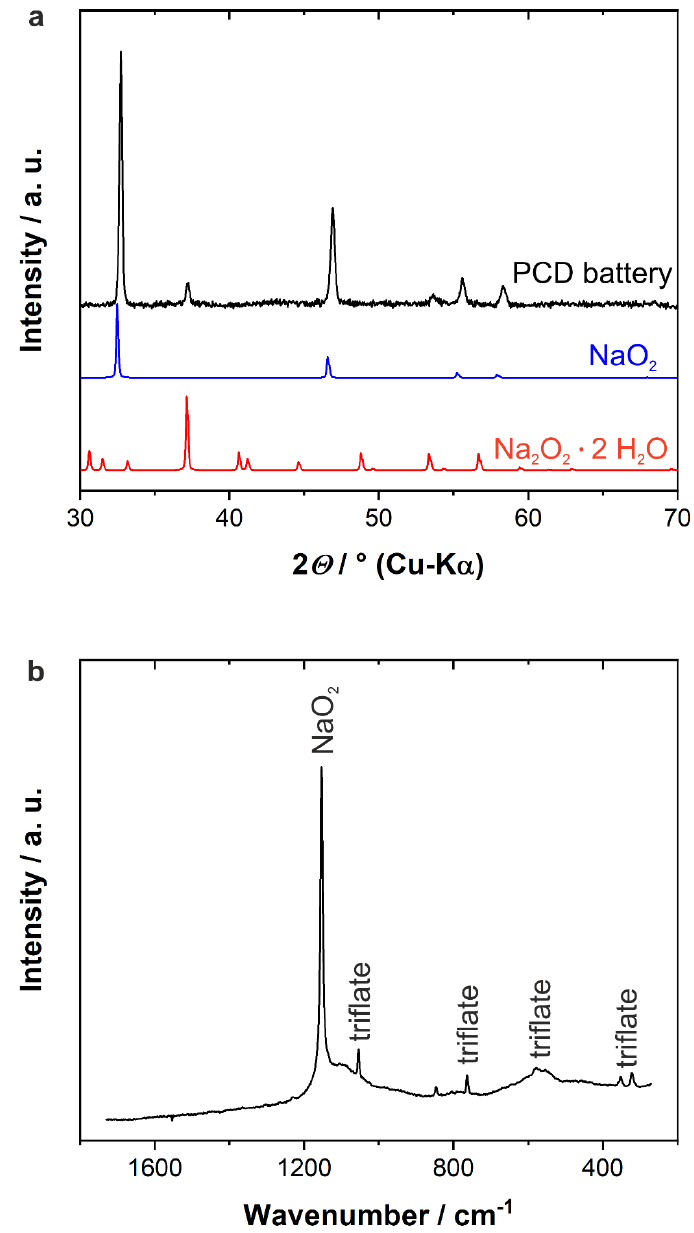
Figure 3. Ex situ XRD and Raman measurements of a cathode of one Na/O 2 battery that was discharged at 500 µA cm −2 to the cut-off potential of 1.6 V vs. Na + /Na by applying the pulse discharging protocol with 1 s pulse time and 10 s resting at OCV. ( a ) Reference X-ray diffractograms for NaO 2 (blue) and hydrous Na 2 O 2 are provided to assign the reflexes of the PCD battery (black). Raman signals in ( b ) are assigned based on Raman measurements from previous work [3,49]. Due to the degradation of NaO 2 over time, the round trip efficiency for charge and discharge of the Na/O 2 batteries decreases dramatically when applying such high t rest /t pulse ratios during pulse discharging due to the higher overpotentials from Na 2 O 2 decomposition at subsequent charging